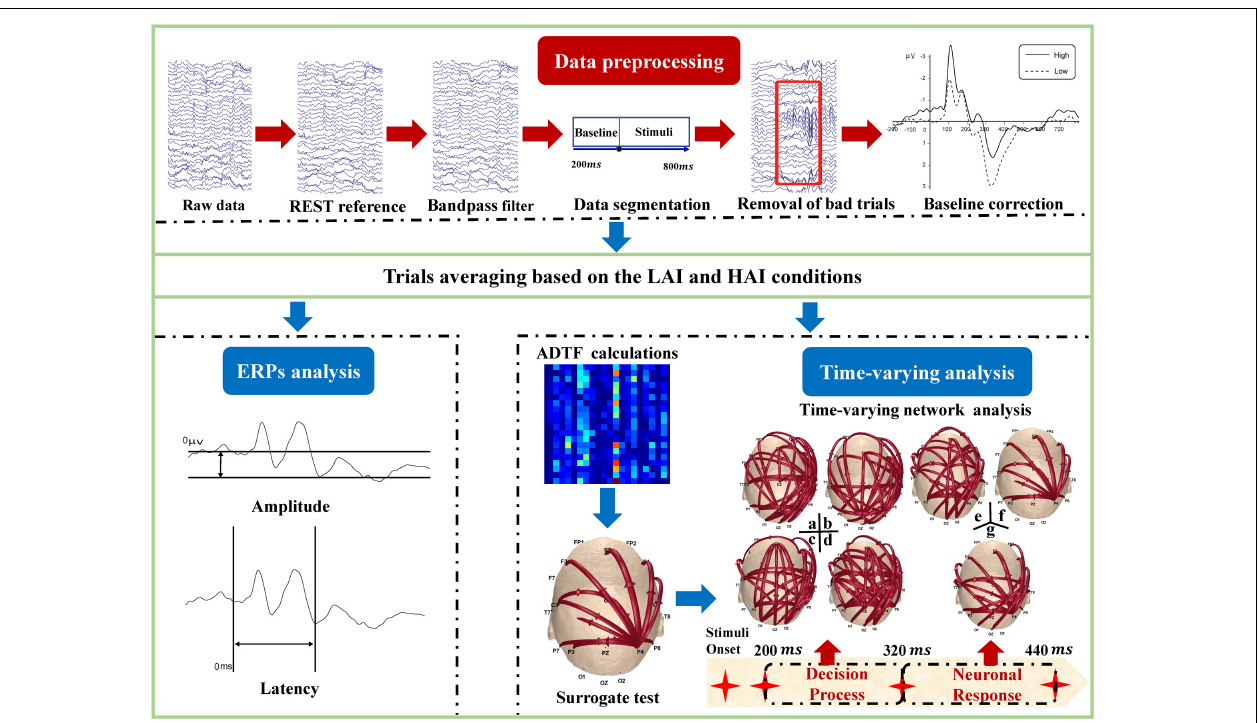
FIGURE 2 | Electroencephalogram (EEG) data analysis procedure. EEG data preprocessing, event-related potentials (ERPs) analysis, and time-varying analysis were involved in the analysis protocol.